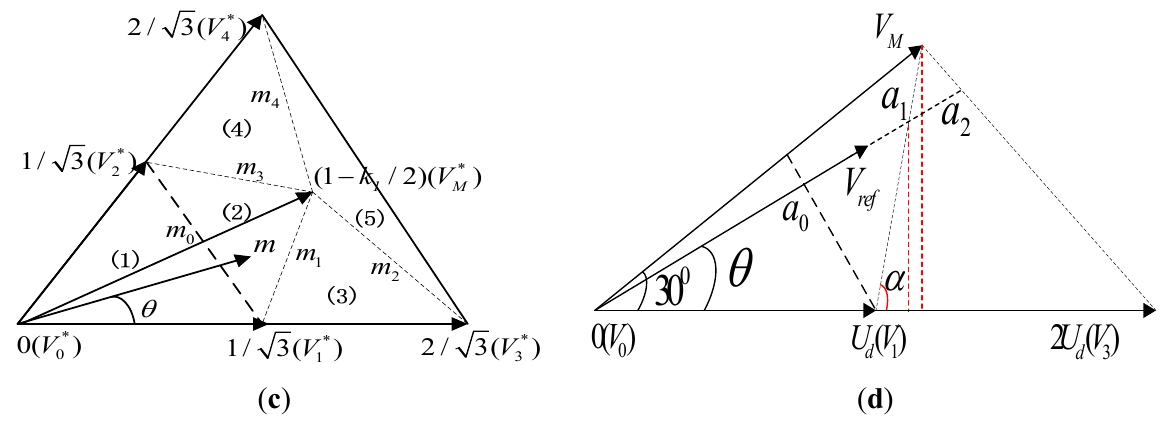
Figure 2. Distribution of varied virtual space voltage vectors in sextant I; ( a ) Definition and distribution of varied virtual space voltage vectors in sextant I; ( b ) Virtual space voltage vectors in g_h coordinate; ( c ) Distribution diagram of varied virtual vectors in Sextant I (60° Sextant); ( d ) The calculation of m 1